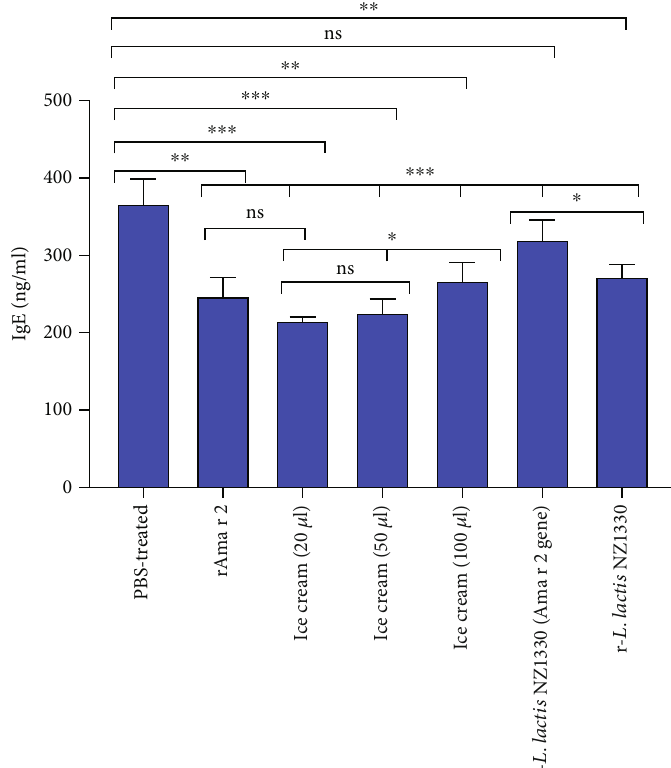
Figure 8: Total serum IgE levels after immunotherapy. ns: not signi fi cant; ∗∗∗ p < 0 : 001 , ∗∗ p < 0 : 01 . and ∗ p < 0 : 05 versus the normal or PBS- treated group. Normal group: untreated and unsensitized group (PBS and alum-sensitive and treated with PBS), PBS-treated group: sensitized with rAma r 2 and PBS-treated, rAma r 2 group: sensitized with rAma r 2 and treated with pure rAma r 2 at a concentration of 40 μ g/ml, ice cream (20 μ l): sensitized with rAma r 2 and treated with 20 μ l ice cream containing r- L. lactis NZ1330, ice cream (50 μ l): sensitized with rAma r 2 and treated with 50 μ l of ice cream containing probiotic bacteria, ice cream (100 μ l): sensitized with rAma r 2 and treated with 100 μ l of ice cream containing r- L. lactis NZ1330, r- L. lactis NZ1330 (Ama r 2 gene): sensitisized to rAma r 2 and treated with probiotic bacteria r- L. lactis NZ1330 which contains the Ama r 2, and r- L lactis NZ1330: sensitized with rAma r 2 and treated with probiotic bacteria lacking the Ama r 2